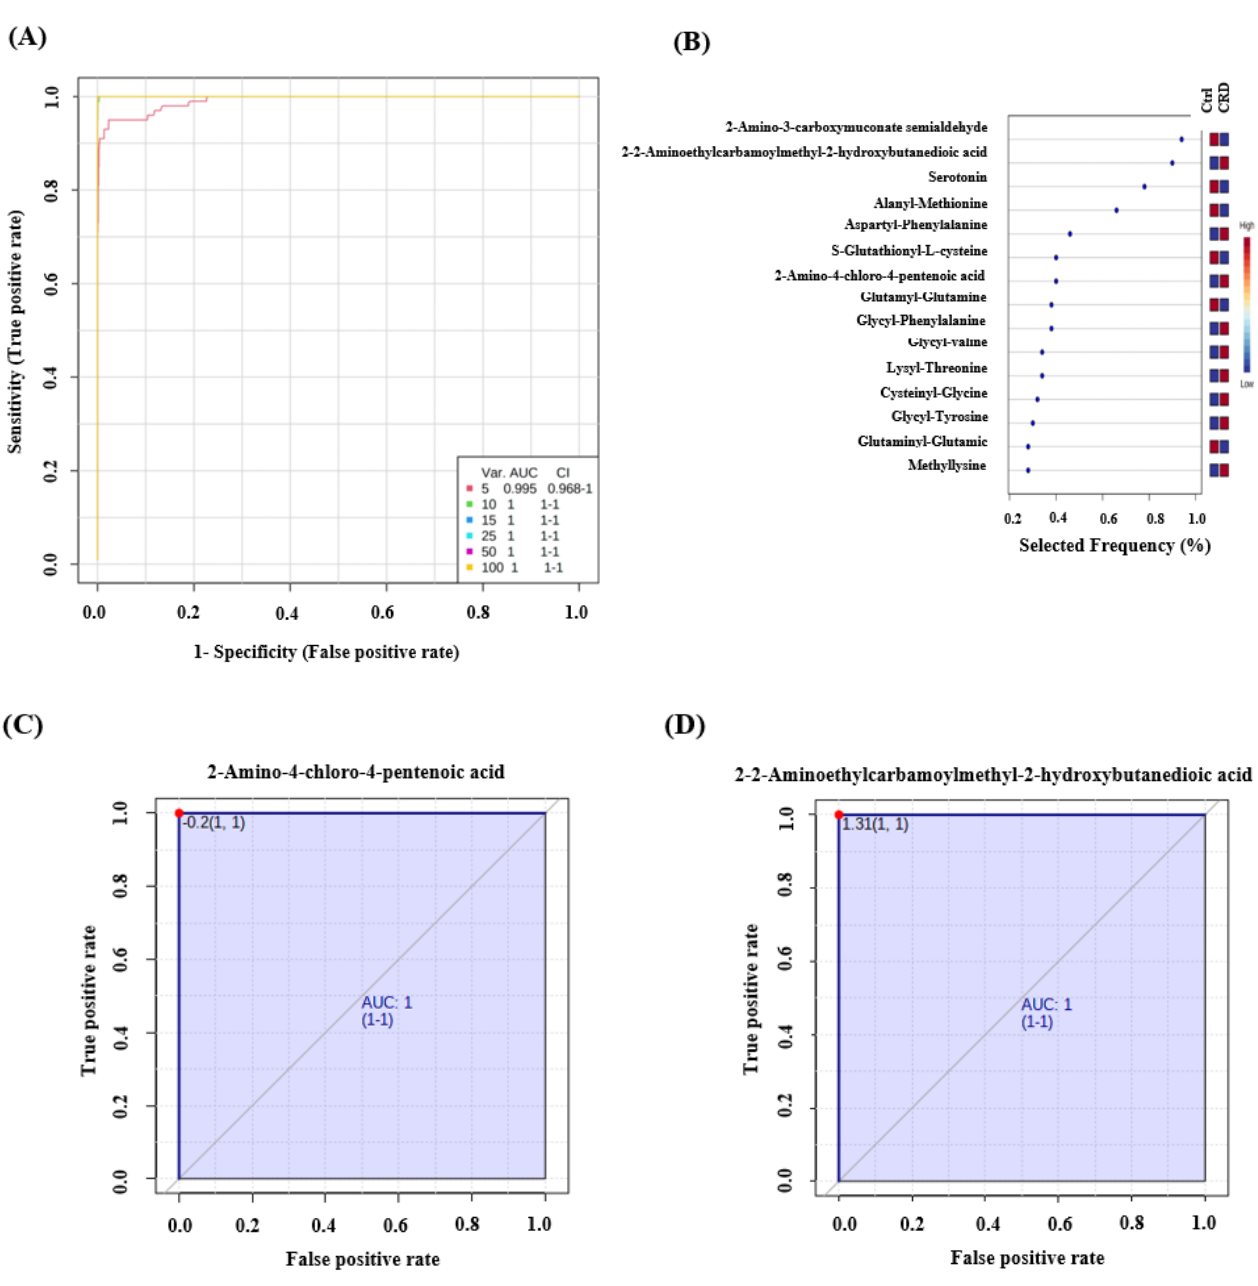
Figure 5. Receiver operating characteristics (ROC) curve and loading plots for significant metabolites in serum patients with cystic renal diseases. ( A ) ROC was generated by the PLS-DA model showing area under the curve (AUC) = 0.995–1 ( B ) Loading plots showed frequently expressed metabolites in CRD patients compared to the Ctrl group. ( C ) 2-Amino-4- chloro-4-pentenoic acid and ( D ) 2-[(2-Aminoethylcarbamoyl) methyl]-2-hydroxybutanedioic acid are up-regulated in CRD patients (AUC-1).